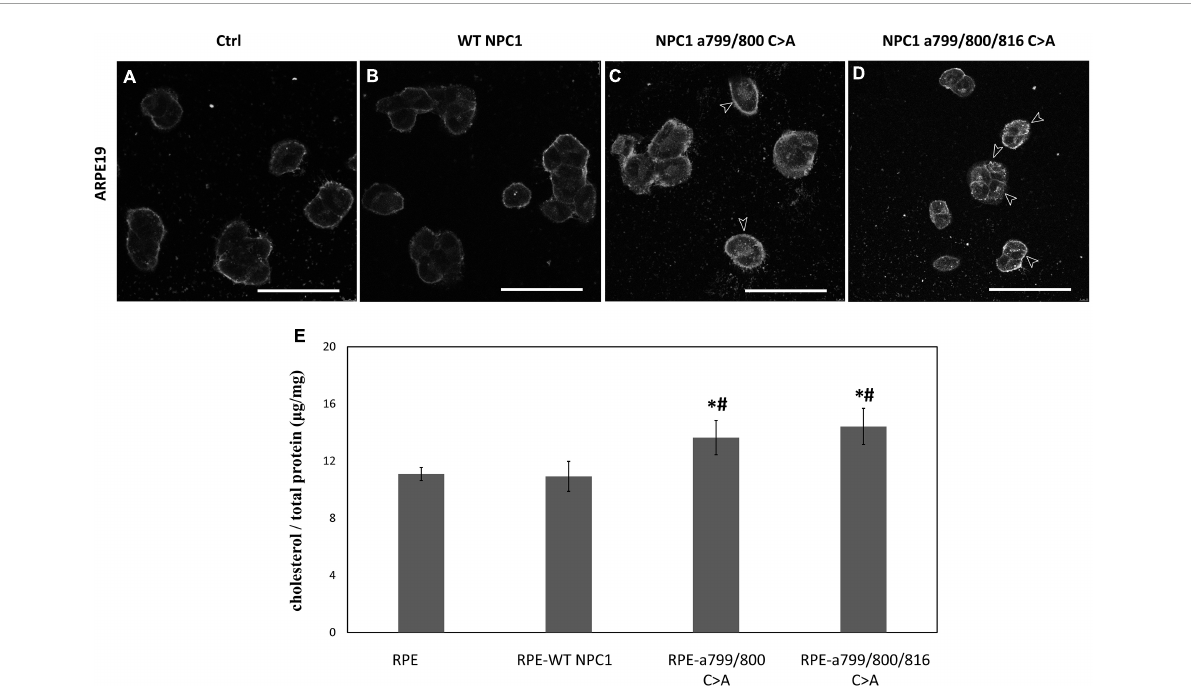
FIGURE8 Cholesterol accumulation in ARPE19 cells expressing wildtype and mutated NPC1 proteins. (A–D) Filipin staining of ARPE19 cells transfected with wildtype (WT NPC1) and mutated NPC1 as indicated. IN mock- and wildtype NPC1-transfected cells, only plasma membrane showed discernable cholesterol labeling. The introduction of double- and triple-mutated NPC1 caused visible intracellular cholesterol accumulation as indicated by arrows. (E) Quantification of intracellular cholesterol in normal ARPE19 cells (RPE) and after wildtype (RPE-WT NPC1), and mutated NPC1 transfection as indicated. The scale bar denotes 50 µ m. ∗ Indicates a significant difference when compared to normal PRE cells and # Indicates a significant difference when compared to RPE-WT NPC1 cells ( p < 0.05 by unpaired t